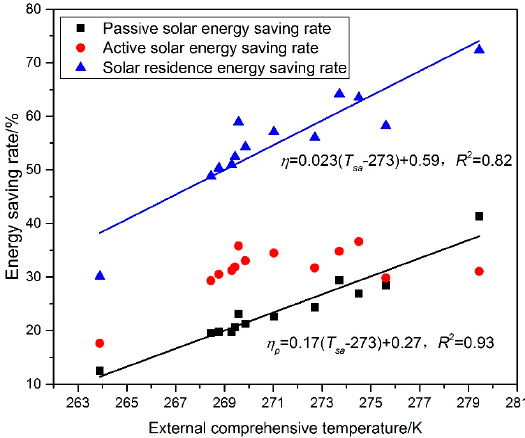
Figure 9. Relationship between energy saving rate and external comprehensive temperature.